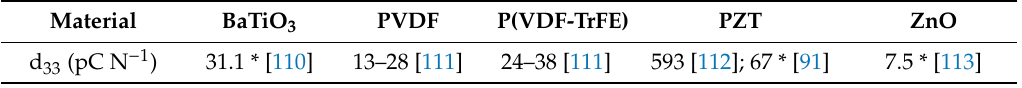
Table 1. d 33 of the most used piezoelectric